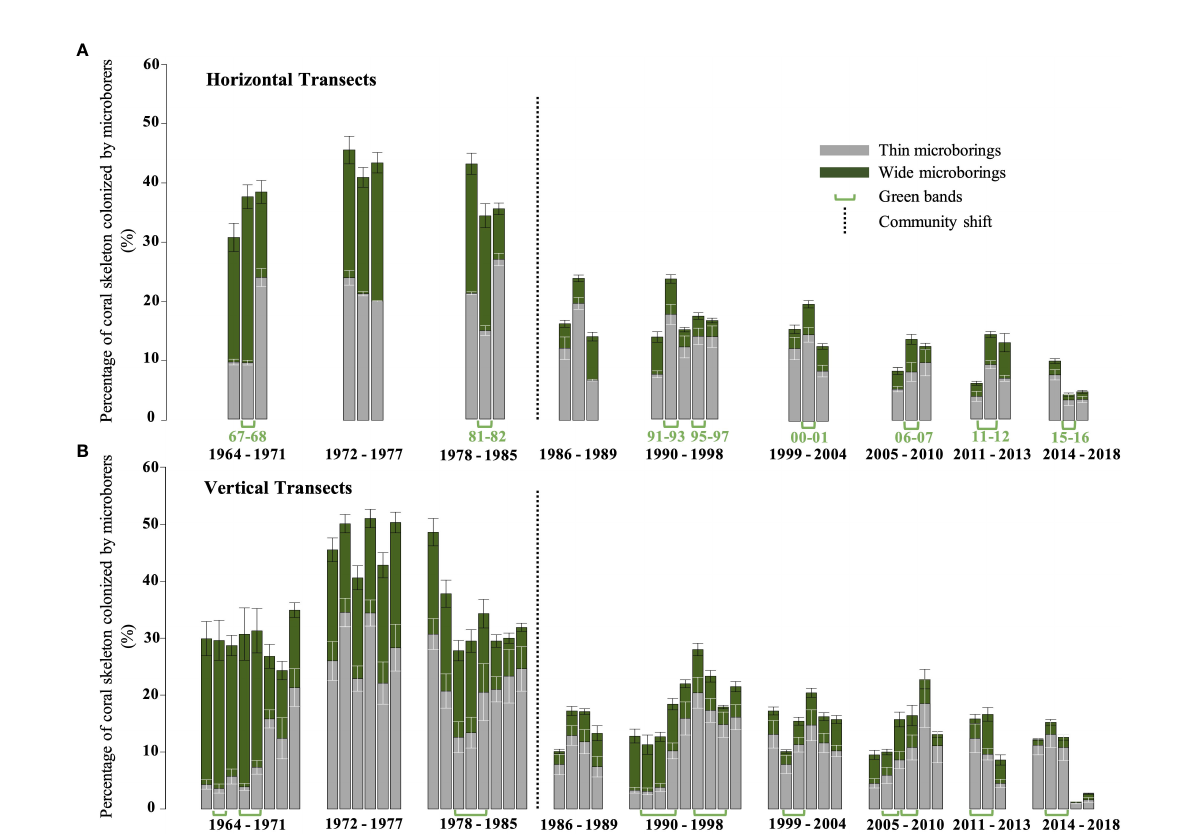
FIGURE 9 Variability of the percentage of coral skeleton colonized by microborings (thin and large traces) over the last 54 years. (A) Histogram reporting the variability obtained along horizontal transects (white vs green bands). (B) Histogram reporting the variability obtained on vertical transects (each bar represents a year and it is the mean of the 3 vertical transects for each year). Standard errors are indicated by bars at the top of each box. Green arrows specify the position of the visible green bands within the coral core. The black dotted line indicates the breakpoint or traces assemblage